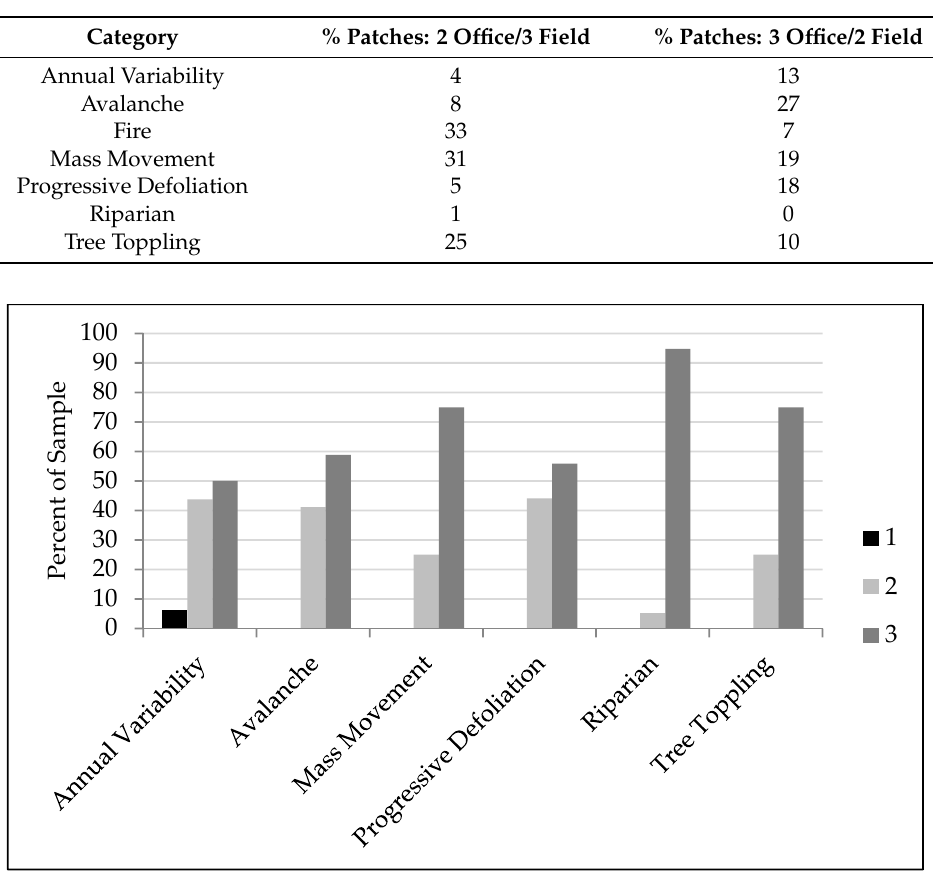
Figure 7. Distribution of confidence values among change categories for labels assigned in the office for randomly selected patches. 5. Conclusions and Recommendations As computational and algorithmic advances improve our ability to map natural change processes over broad landscapes, the assessment datasets used to evaluate the maps must similarly improve. The cost of conducting field visits to build reference or validation datasets can limit sample size, making methods that are based on aerial photo interpretation conducted in an office setting attractive. This is particularly the case in the large wilderness parks of Washington state, U.S.A., where access for field visitation is time consuming and costly, but where inventories of natural disturbance processes are important to understand landscape dynamics inside and outside protected areas. In order to optimize our validation effort, we compared the relative strengths of field versus office-based validation of landscape change in Mount Rainier, North Cascades Complex, and Olympic National Parks.